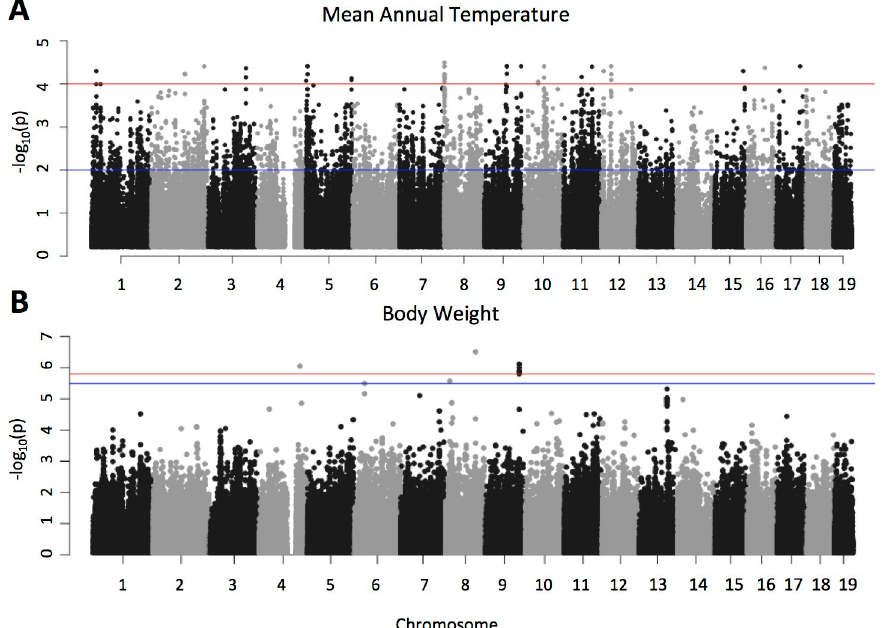
Fig 4. Manhattan plots depicting the results of A) a population genomic scan for selection using LFMM (blue line indicates q-value = 0.05 and the red line indicates q-value = 0.001; B) a genome-wide association study of body weight using 38 mice from the western transect (blue line indicates a q-value = 0.01 and the red line indicates a q- value =